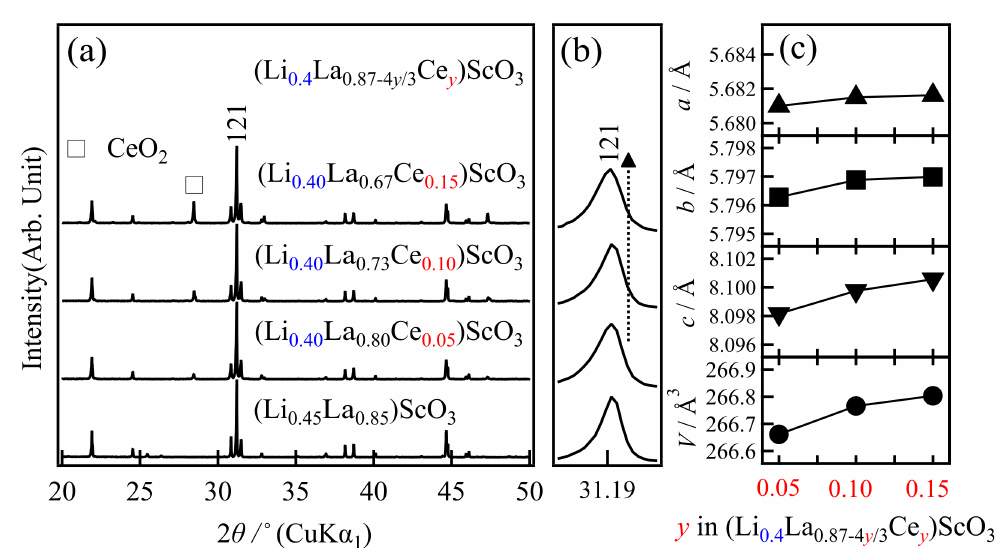
Figure 3. Variation in ( a , b ) the X-ray diffraction patterns, and ( c ) the lattice parameters based on the composition of the as-prepared (Li 0.4 La 0.87 − 4 y /3 Ce y )ScO 3 ( y = 0.05, 0.10,